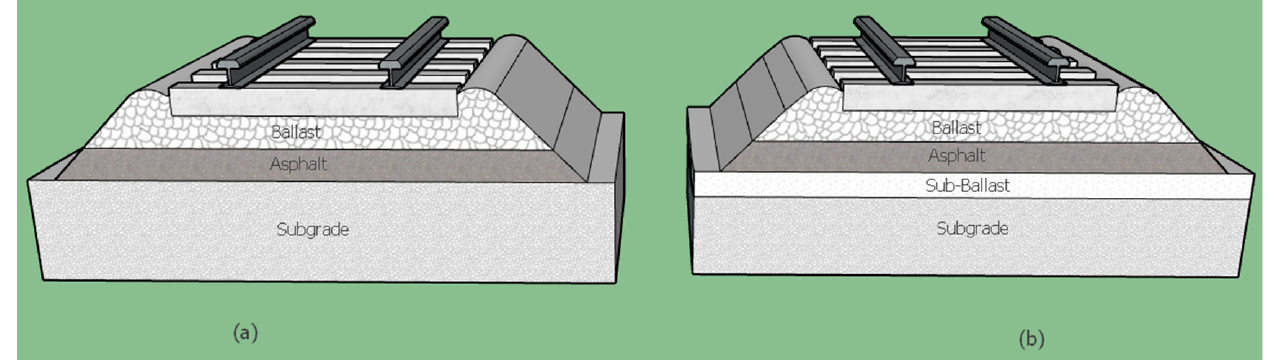
Figure 1. Schematic of combinations of asphalt layers in a ballasted track bed: ( a ) asphalt as a sub-ballast and ( b ) asphalt between the ballast and the sub-ballast.